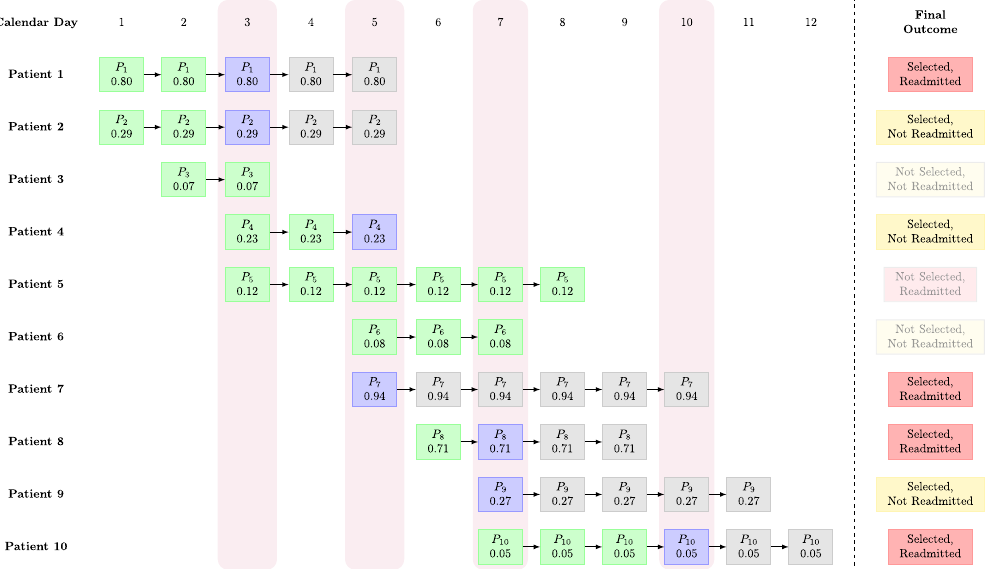
Fig. 2 Visualization of an example of the provider work fl ow in the simulation. Each square cell is a postoperative patient in the hospital on a particular day. Within each cell, P i indicates the i th patient, while the number underneath indicates the predicted readmission probability on that day (e.g., for patient 1 on day 1, this is 0.80). If there is no square cell, then the patient has either not yet completed surgery, or has been discharged. For example, patient 5 completes surgery on day 3 and is discharged on day 8; before day 3, the patient is either still in surgery or has not yet been admitted; after day 8, the patient is no longer present in the hospital. The vertical rectangles shaded in light purple indicate days on which the provider selects patients. In this example, we assume that the provider works on days 3, 5, 7, and 10, and has a capacity of two patients, i.e., the provider can select at most two patients to apply the intervention to on each of those four days. On a given day, if a patient is available for selection and has not yet been selected, they are shaded in green. On a given day, if the provider selects them, they are shaded in blue. After the provider selects them and applies the intervention pathway, the patient is shaded in gray for the remaining days of their hospital stay. As an example of the provider selection process, observe that on day 3, there are 5 postoperative patients available (patients 1, 2, 3, 4, and 5). The provider selects patients 1 and 2, because these two patients have the highest predicted probability of readmission (0.80 and 0.29, respectively). After patients 1 and 2 have been selected, they cannot be selected again; for the remaining days that those two patients are in the hospital, they are indicated with the gray square cells. Notice that patient 4, who was not selected on day 3, is later selected by the provider on day 5; in this case, patient 4 was not among the top two patients on day 3 but became one of the top two patients on day 5. On the other hand, patient 3 is discharged before day 5; thus, this patient is lost and never ends up receiving the intervention pathway. We also note that on day 10, the provider only selects one patient (patient 10), because the other two patients (patients 7 and 9) were already selected previously (days 5 and 7, respectively). The rectangular cells on the right summarize the fi nal outcome with each patient, with regard to whether or not they were selected by the provider, and whether or not they eventually experienced an ED readmission. In this example, there are a total of 7 patients who are selected, so the patients seen (PS) metric is 7. The number of patients selected and who get readmitted is exactly 4, so the RA metric is 4. Assuming an effectiveness constant of 10%, the ERP metric is 4 × 10% =